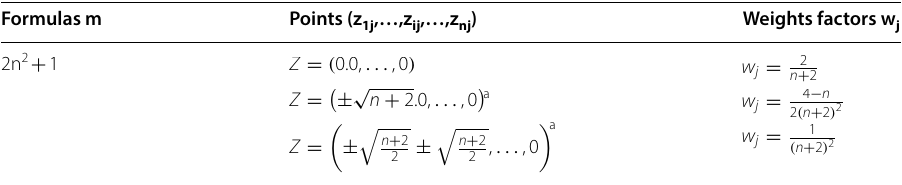
a Points include all possible permutations of coordinates